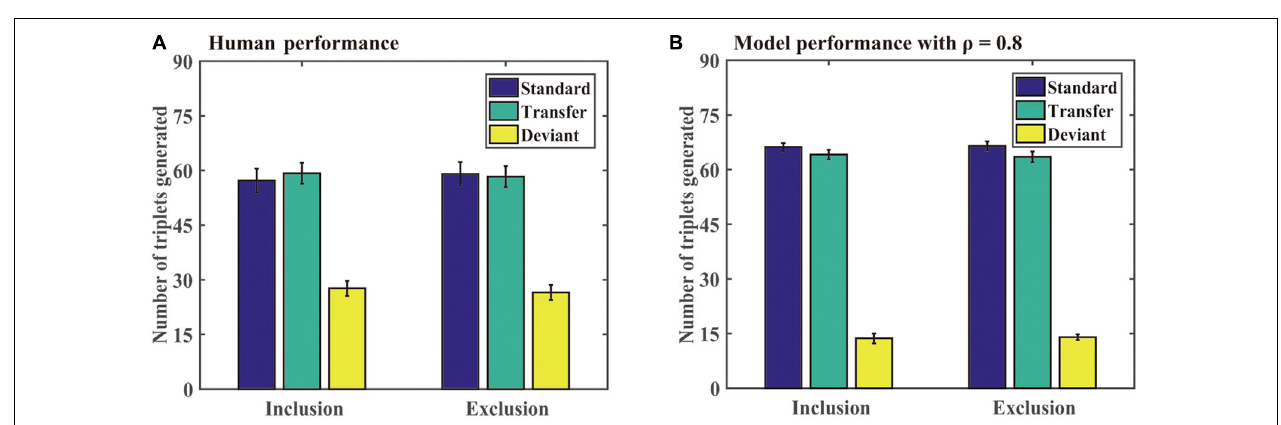
FIGURE 7 | Human and model performance in the SRT task in Simulation 2. (A) Mean RTs for human participants. (B–D) Mean RTs for models with different ρ values.